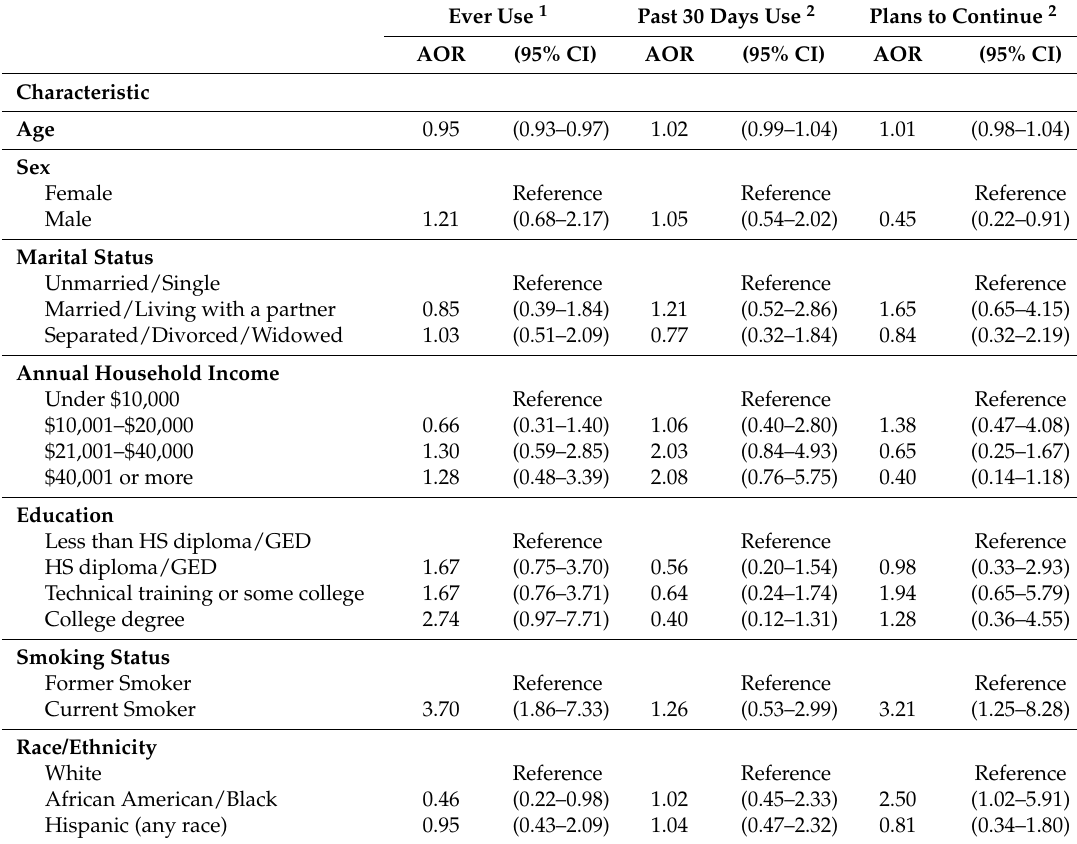
Table 3. Multivariable Logistic Regressions of E-Cigarette Use and Plans to Continue